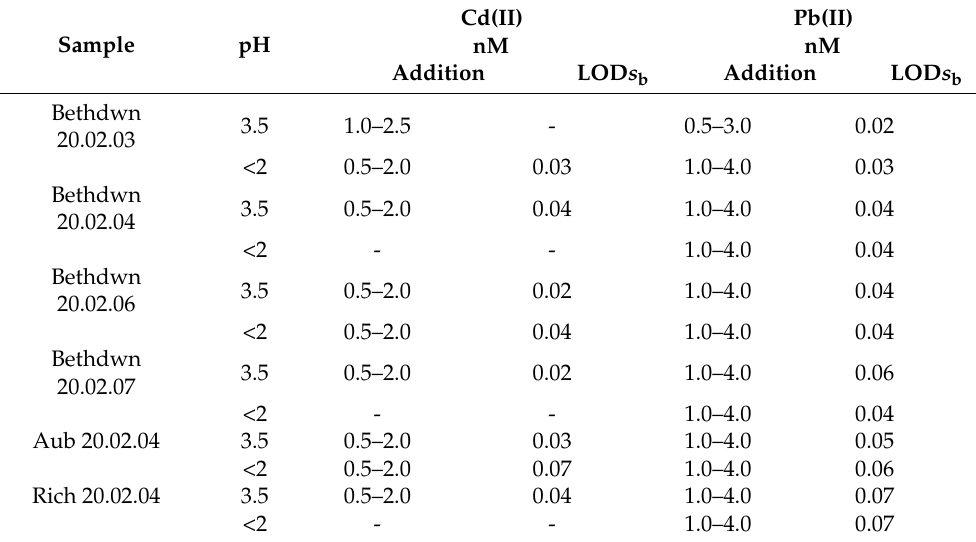
Table 2. Standard addition LODs for Cd(II) and Pb(II) ( t d : 180 s) in the river water samples at pH 3.5 and at pH <